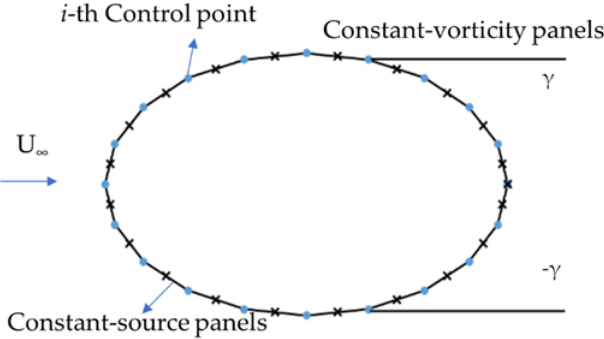
Figure 2. Sketch of boundary discretisation and separated-flow model.